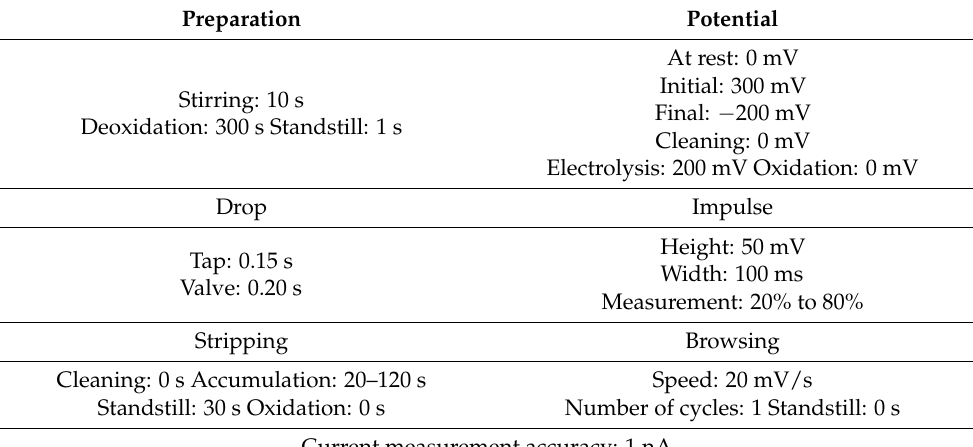
Table 2. Parameters of chloride determination carried out using the polarographic